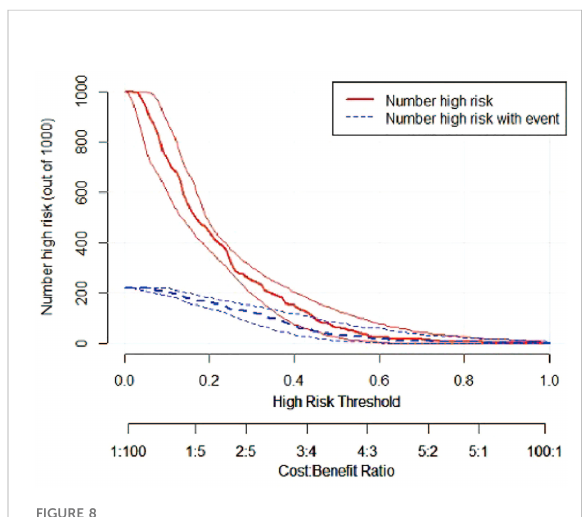
FIGURE 8 CIC of the risk prediction model for the prediction of bile duct injuries after DEB-TACE in patients with HCC. The red line (i.e., number of high-risk patients) represents the number of patients classi fi ed as positive by the model at each threshold probability, whereas the blue curve (i.e., number of high-risk patients with an outcome) represents the number of patients with true positives at each threshold